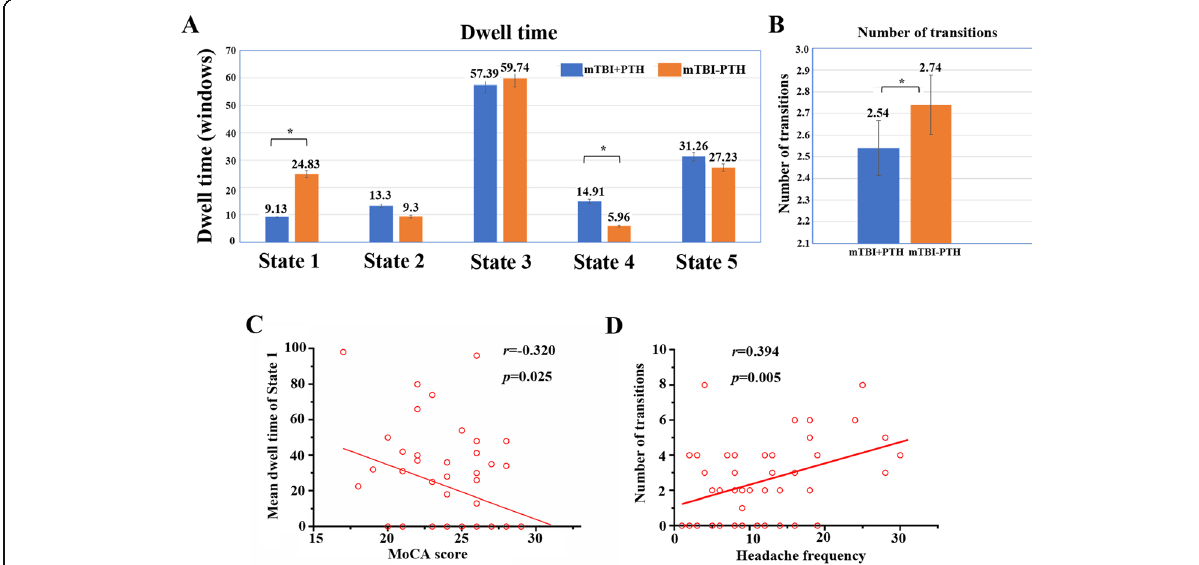
Fig. 5 Temporal properties of functional connectivity state analysis and correlation of clinical variables with temporal properties for mTBI with PTH patients. A mean dwell time (i.e. number of consecutive windows spent in each state before switching) and ( B) number of transitions (i.e. switching between states) is depicted for mTBI with PTH and mTBI without PTH with error bars. Asterisk represent a significant group difference ( p <0.05, FDR corrected). C the mean dwell time of state 1 was negatively correlated with MoCA score. D the number of state transitions was positively associated with the headache frequency in mTBI with PTH patients (all p <0.05, FDR